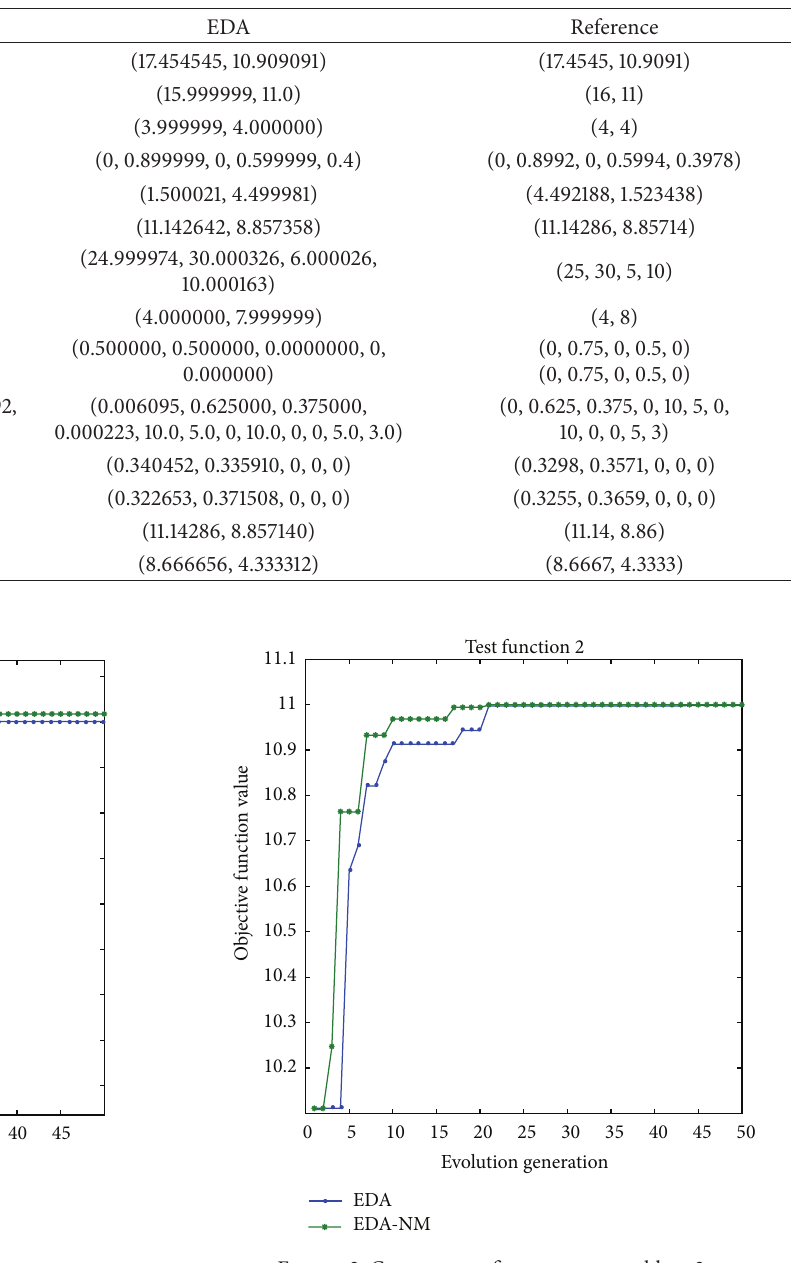
Table 3: The best solution found by EDA-NM, EDA, and compared algorithms in the corresponding references.